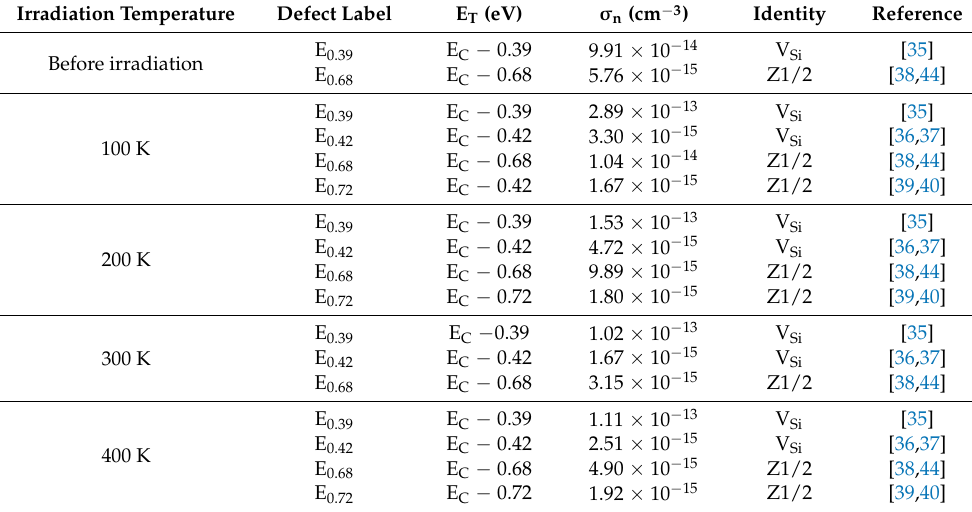
Table 1. Defect parameters obtained from the DLTS measurements.